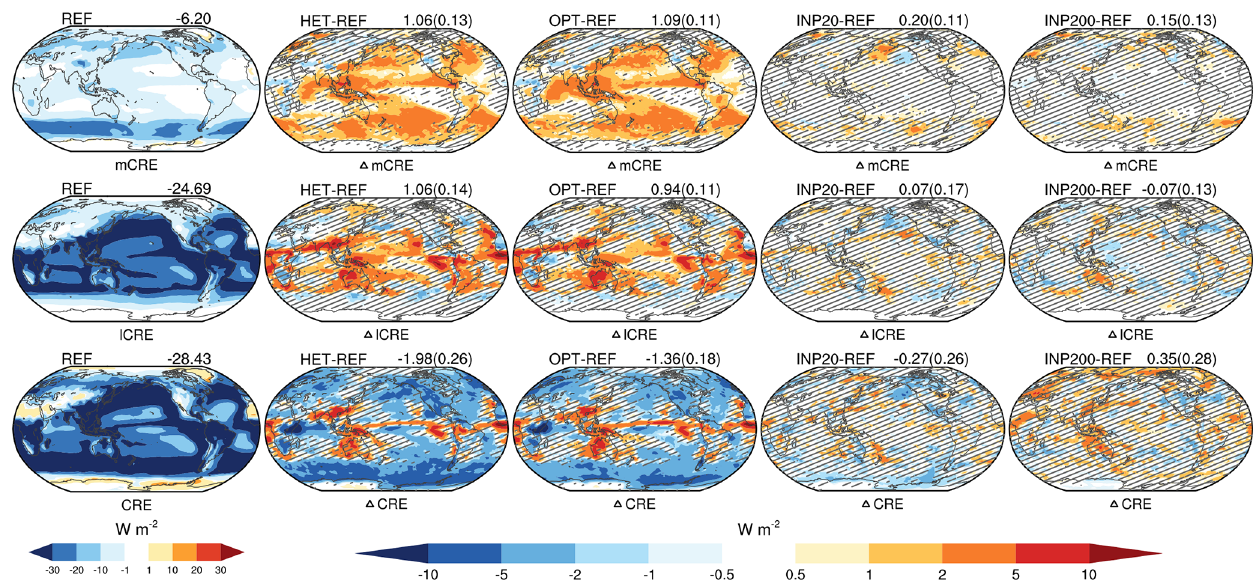
Figure 5. Similar to Fig. 4 but for the mixed-phase cloud radiative effect (mCRE, first row), liquid cloud radiative effect (lCRE, second row), and the all cloud radiative effect (CRE, third